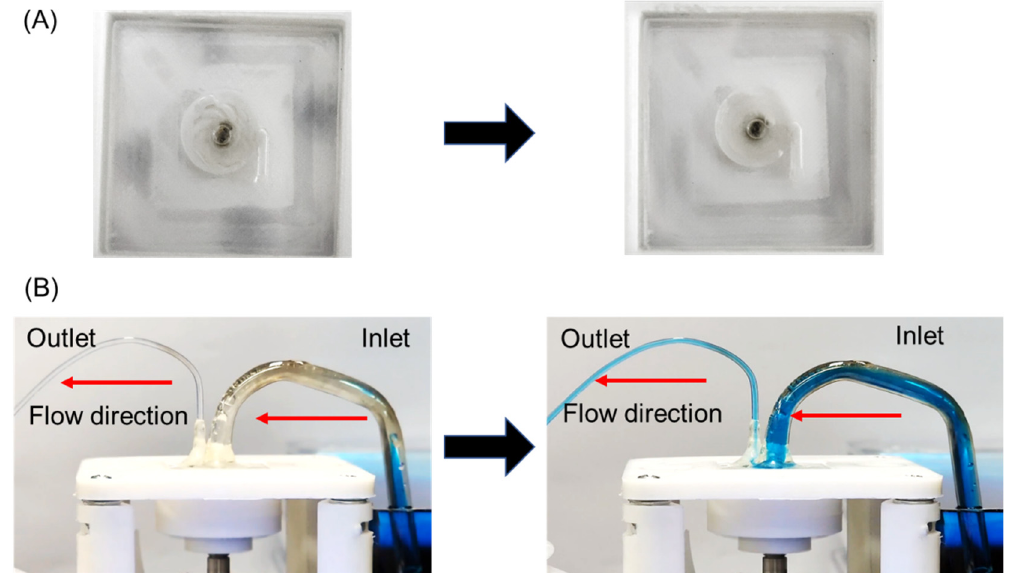
Figure 5. Operation results of the glass micropump. ( A ) Impeller rotation ( B ) Liquid suction and discharging.